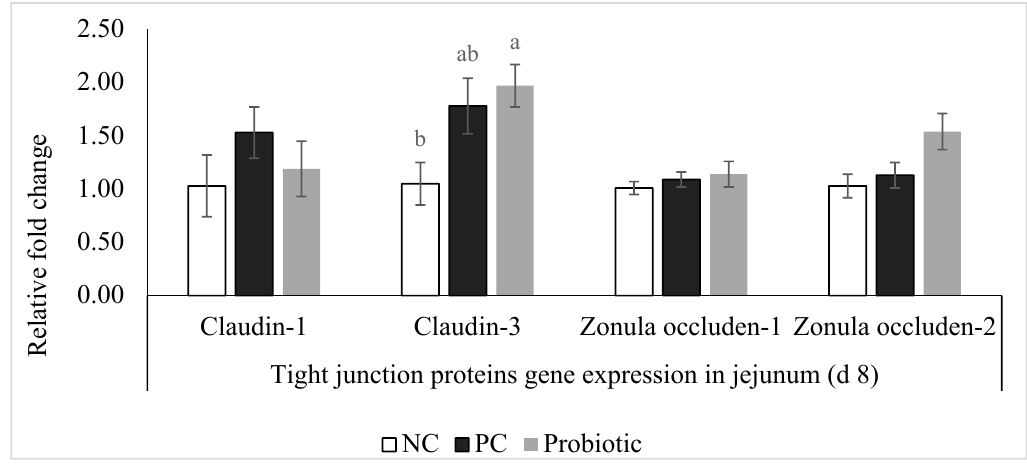
Figure 1. Relative gene expression of tight junction proteins in the jejunum of broiler chickens on d 8. Birds reared under a naturally occurring necrotic enteritis challenge model. Treatments include: negative control (NC): birds received a corn-soybean meal basal diet; positive control (PC): NC + virginiamycin (Stafac ® 20) at the level of 0.45 kg/ton from d 0-42; Probiotic: NC + PrimaLac at the level of 1.36 kg/ton in starter and grower 1 diets; 0.91 kg/ton in grower 2 and finisher diets. Values are represented as a n -fold difference relative to the calibrator (negative control, NC). Results are given as means ( n = 12) for each treatment. Error bars indicate standard errors. For each gene, bars with different letters are significantly different ( P < 0.05).